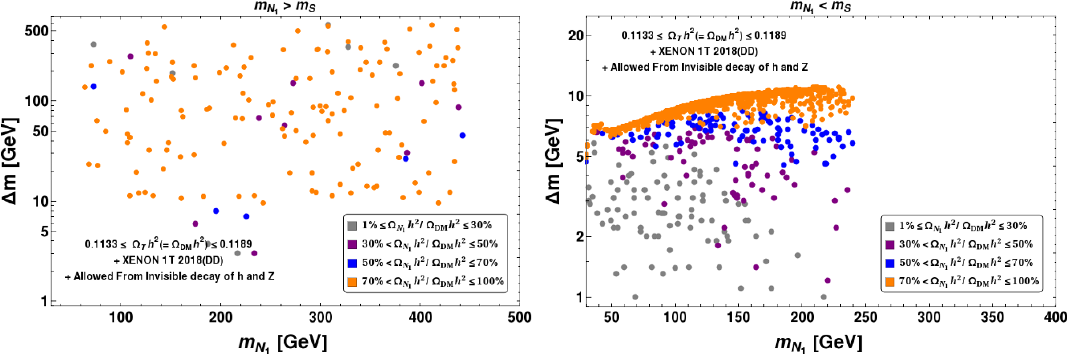
Figure 13 . Mass correlation of the two DM components in m N sity allowed parameter space is shown by orange points and direct search constraint from XENON 1T [10] on both N 1 and S is shown by blue points. Black solid line corresponding to m N segregates the two possible hierarchies: the one above corresponds to m S > m N below has m S < m N . [Right Panel] Relic density allowed points for di(cid:11)erent ranges of (cid:1) m shown 1 with di(cid:11)erent colour codes.